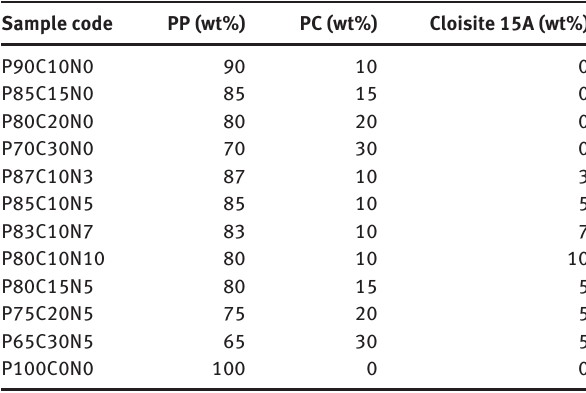
Table 2: Sample codes and